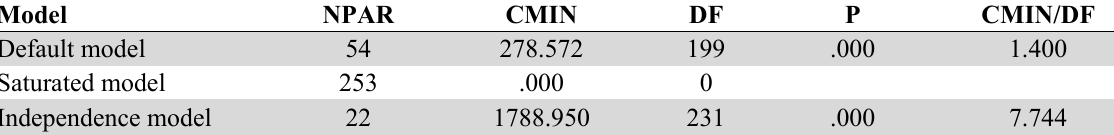
Moderation Test for Female Group Data Constrained Unconstrained Chi-Square Result on Result on Model Model Difference Moderation Hypothesis Chi-Square 285.323 278.572 6.751 Significant Supported DF 200